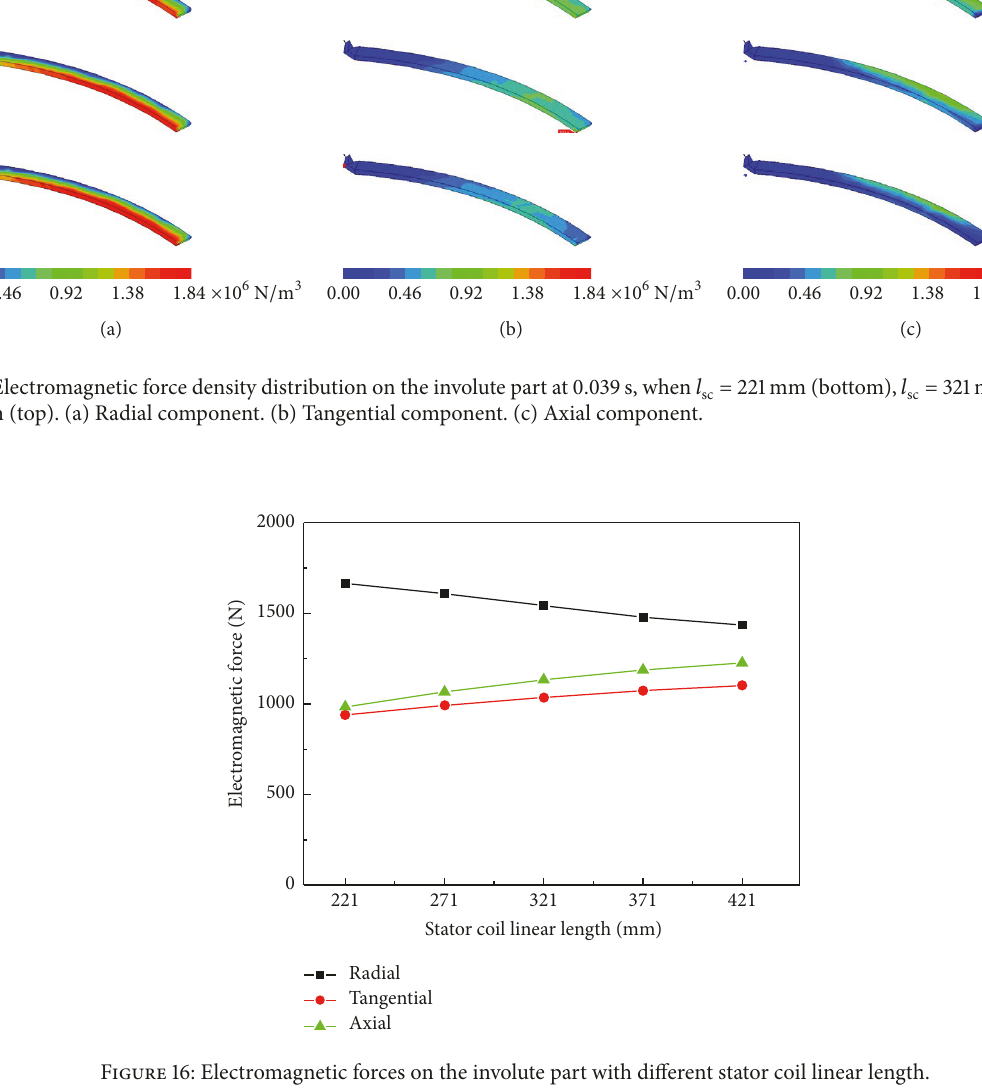
Figure 16: Electromagnetic forces on the involute part with different stator coil linear length.